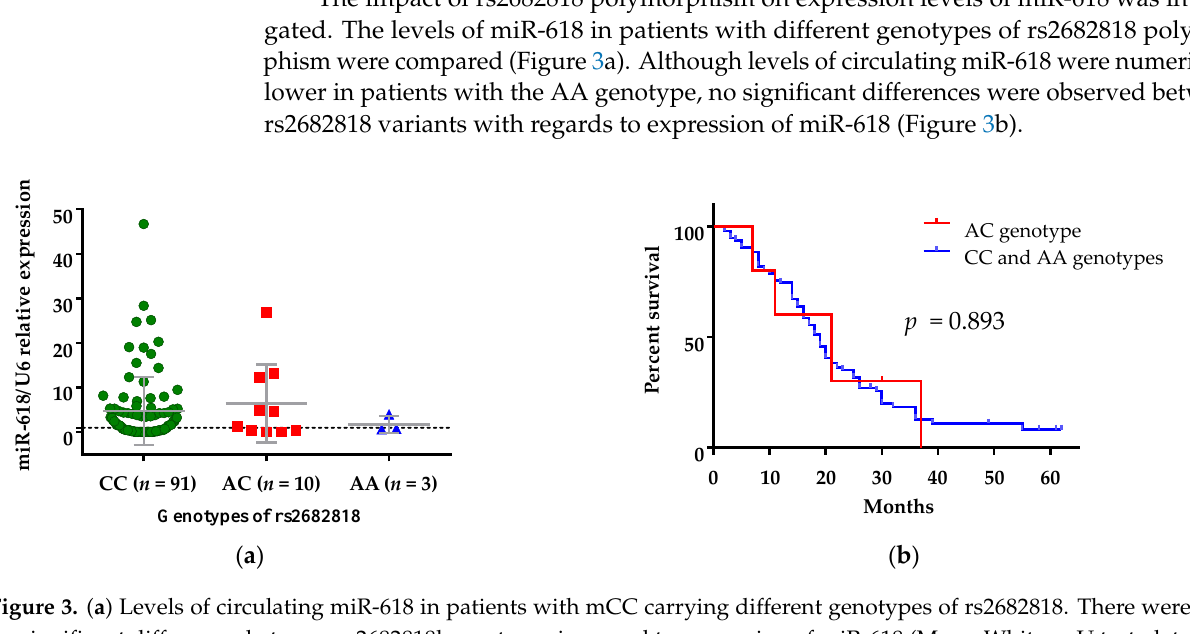
Table 3. Genotypes distribution and allele frequencies of rs2682818 in mCC patients ( n = 104) and healthy controls ( n = 90). Association of rs2682818 SNP with colon cancer.